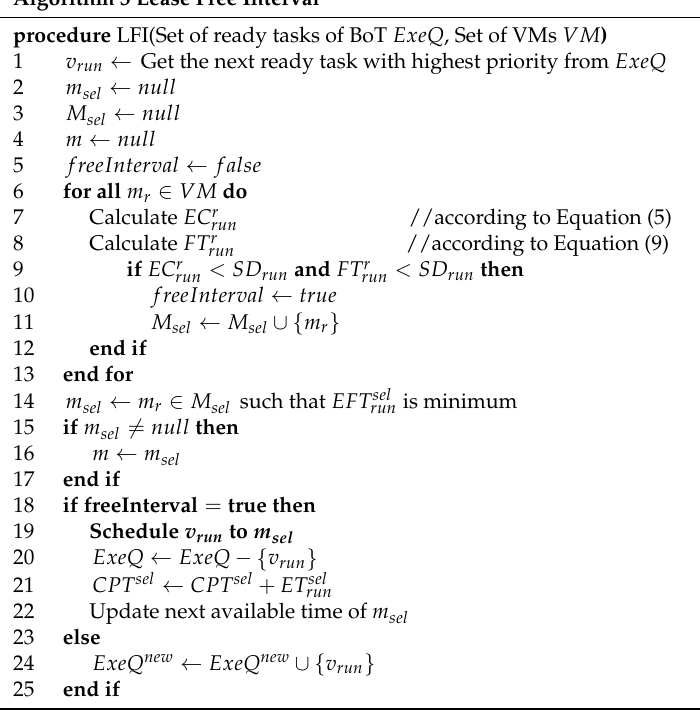
Algorithm 3 Lease Free